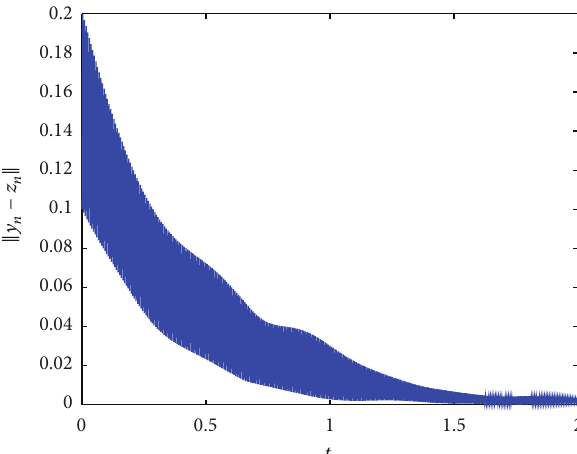
Figure 2: The norm of difference ‖𝑦 𝑛 −𝑧 𝑛 ‖ with step size ℎ = 0.0033